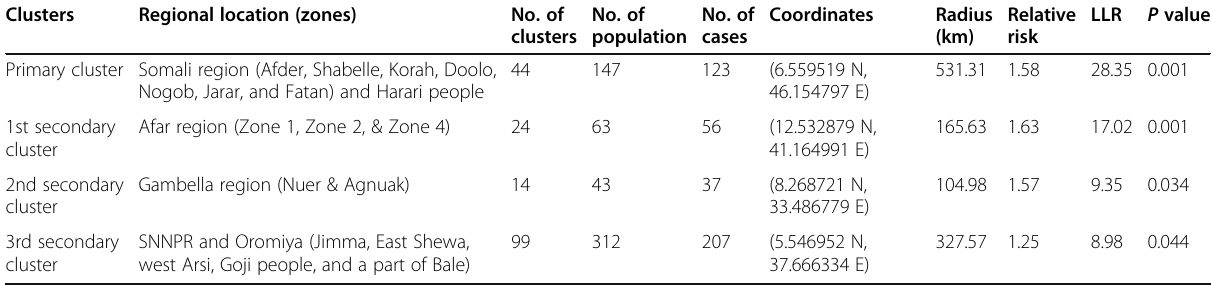
No. of No. of Coordinates Radius Relative LLR P value clusters population cases (km) risk